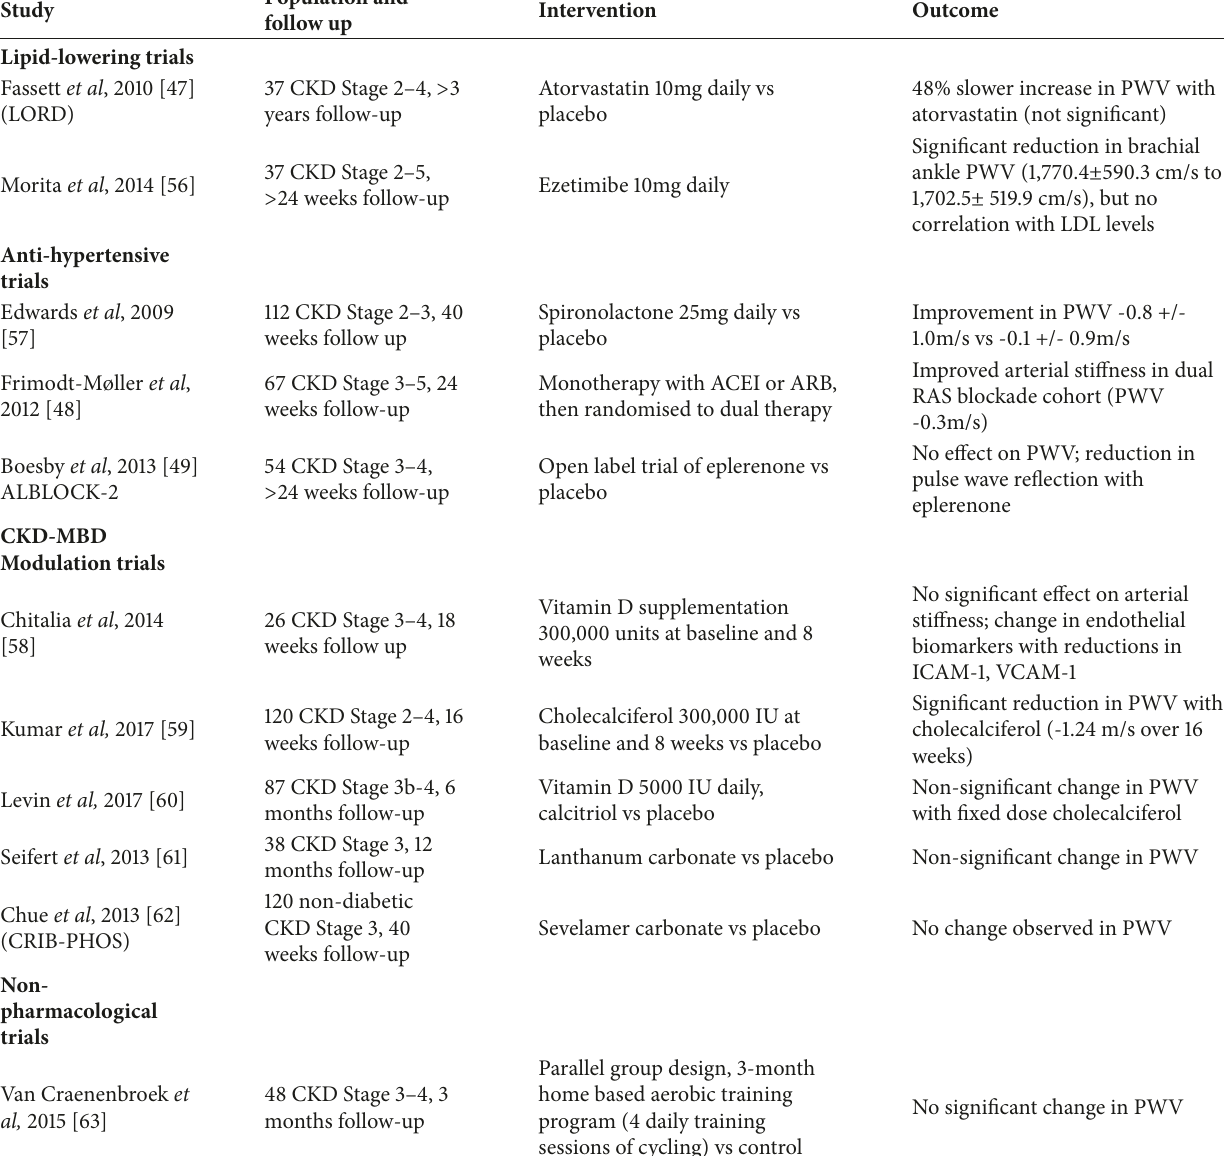
Table 2: Interventional trials in the non-dialysis CKD population using PWV as a reported outcome. Stu d